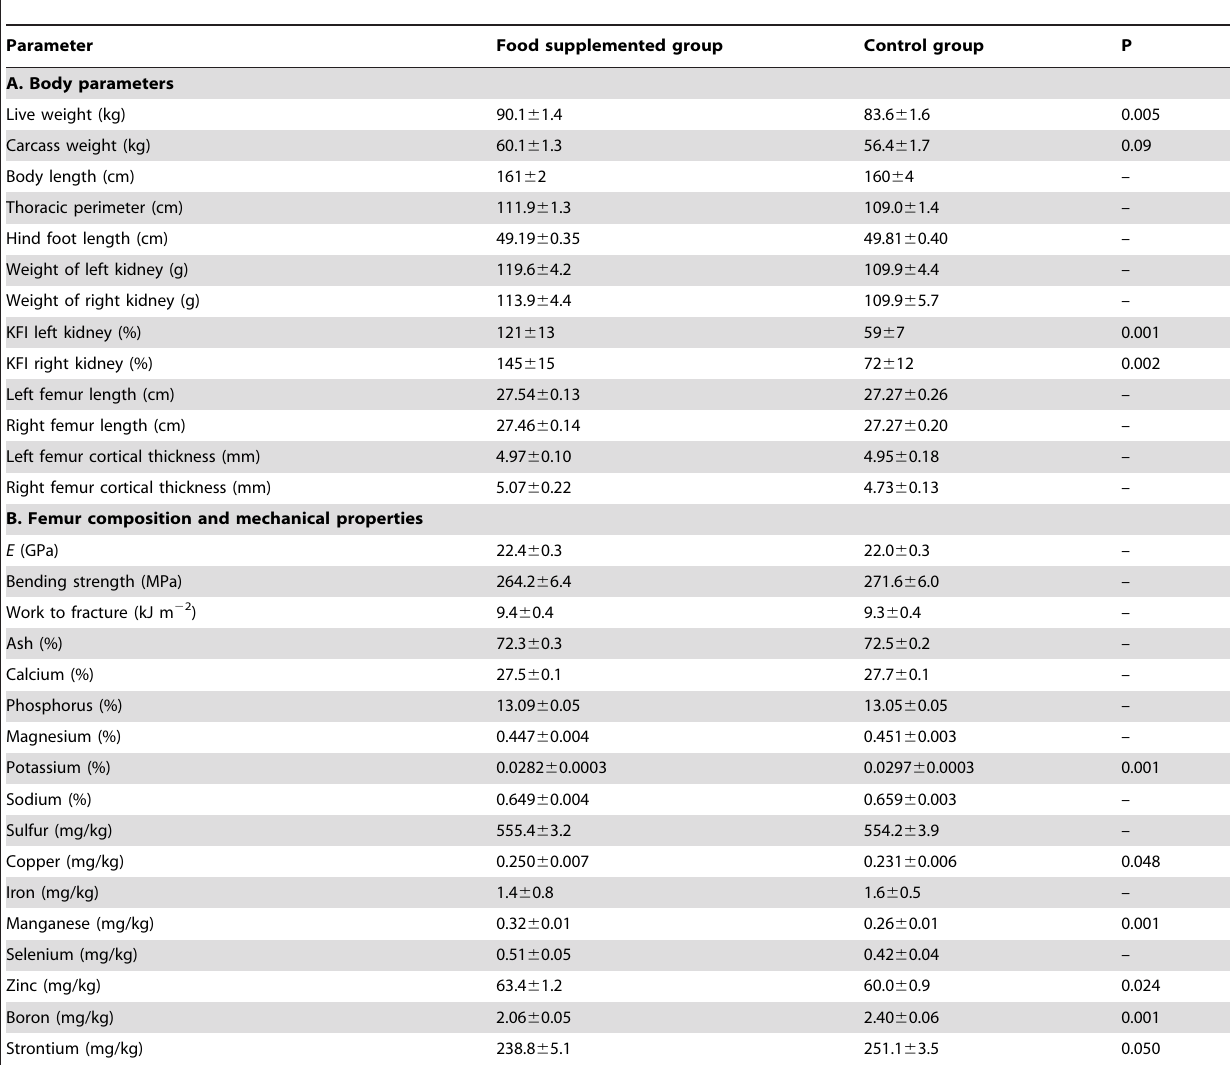
Table 2. Differences in body properties measured (Panel A) and femur mechanical properties, ash and minerals between two groups of red deer hinds feeding on natural vegetation (control group) or plants plus 1 kg animal 2 1 day 2 1 of food supplement indicated in Table 1 (food supplemented